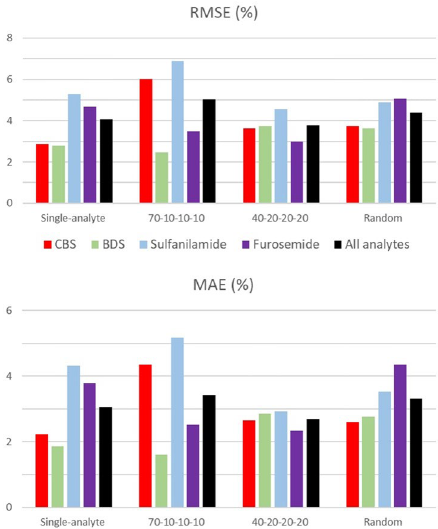
Figure 6. Residual mean square error (RMSE, top) and mean absolute error (MAE, bottom) calculation. The composition of each mixture was estimated using the kinetic parameters and R max , i values identified from different data sets (single-analyte, 70–10–10–10 mixtures, 40–20–20–20 mixtures and random mixtures). The estimated composition was compared to the actual composition of the mixtures outside of the data set used to identify the kinetic parameters. The residual mean square error (RMSE, top) and the mean absolute error (MAE, bottom) were calculated on an analyte basis for CBS, BDS, sulfanilamide and furosemide and by considering all the estimates at once (all analytes). This procedure was repeated for all data